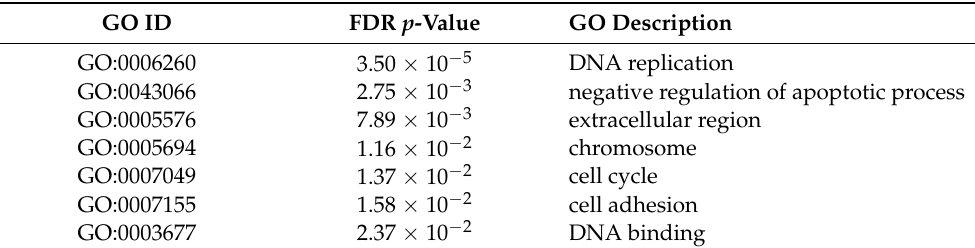
Table 2. Enriched GO terms of upregulated genes at the 20 Days time point in the gill tissue (in response to heat stress).